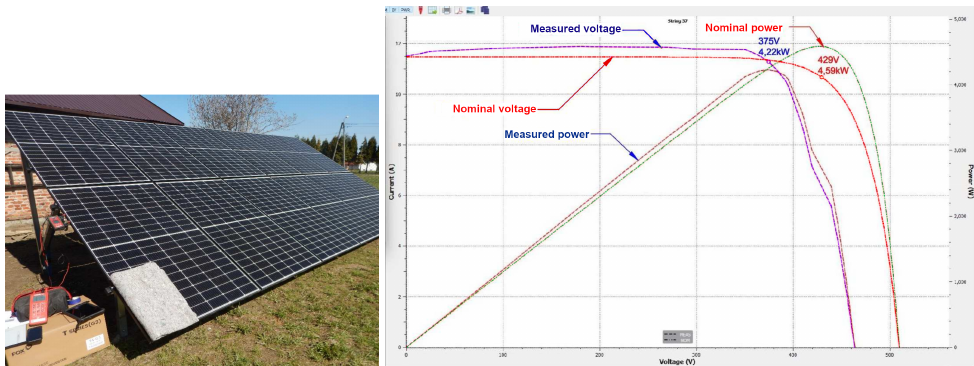
Figure 7. Shading of a small part of the installation ( left inset ) and the measured characteristic of the string ( right inset